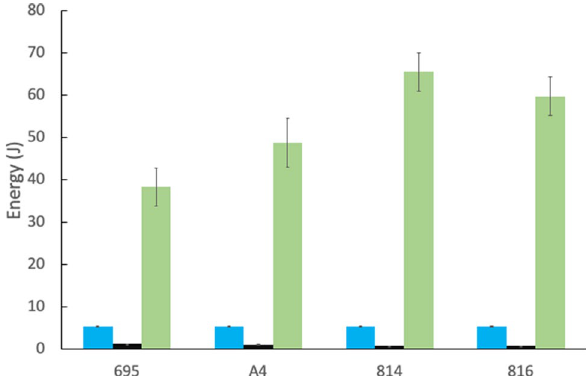
Figure 3. Energy benefits from evaporating nectar during foraging and flight. Average energy (J) needed to transport the reduced crop load back to the hive (blue), energy saved due to reducing body mass by evaporation of crop contents (black) and energy needed to evaporate the excess water in the hive (green). Values are shown for the four cultivars (n = 30 bees per